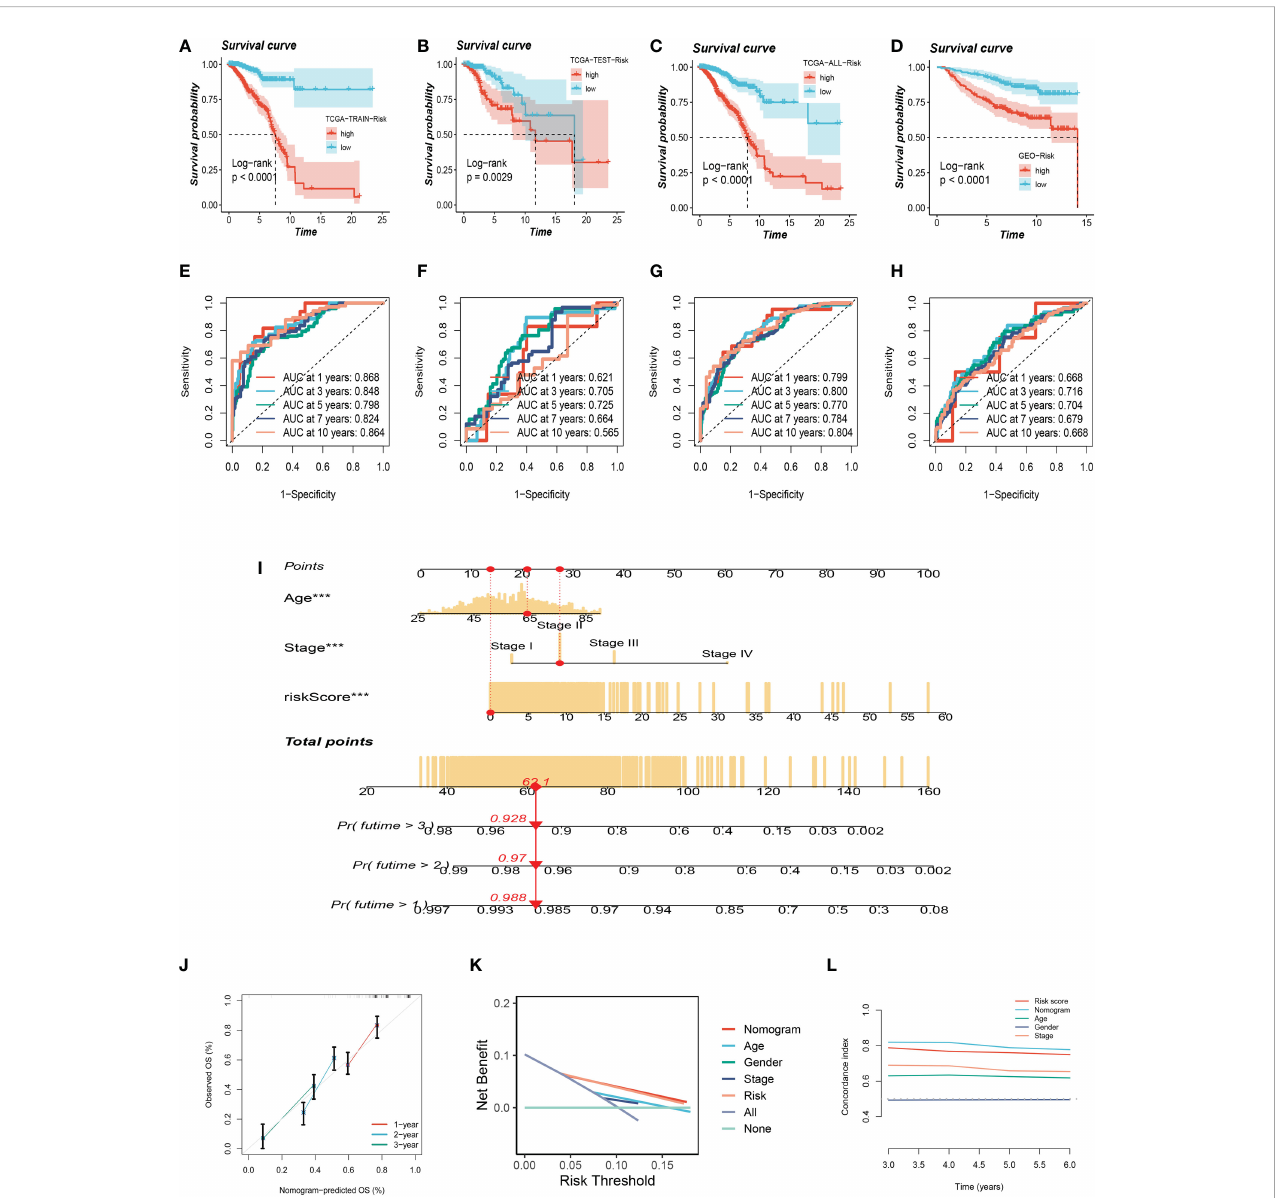
FIGURE 4 Validation of Glutamine-Related Prognostic Model. (A – C) Survival analysis in the TCGA train, test, and entire cohort (P <0.001). (D) Survival analysis in the GEO test cohort. (E – G) The area under the curve (AUC) values for the TCGA train, test, and full cohort. (H) the areas under the curve at 1, 3, and 5 years for the GEO test group. (I) Nomogram to assess the risk of BC patients. (J) Calibration curves for the nomogram. (K) Decision curve. (L) Concordance index study. The *** represents